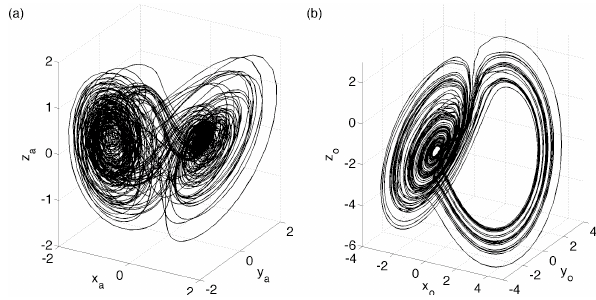
Fig. 2. Mean phase coherence ( γ H ) in black and conditional Lya- punov exponents ( λ fast + and λ slow + ) as a function of coupling strength α . Fast model Lyapunov exponent in solid red and slow model lya- punov exponent in dashed red.